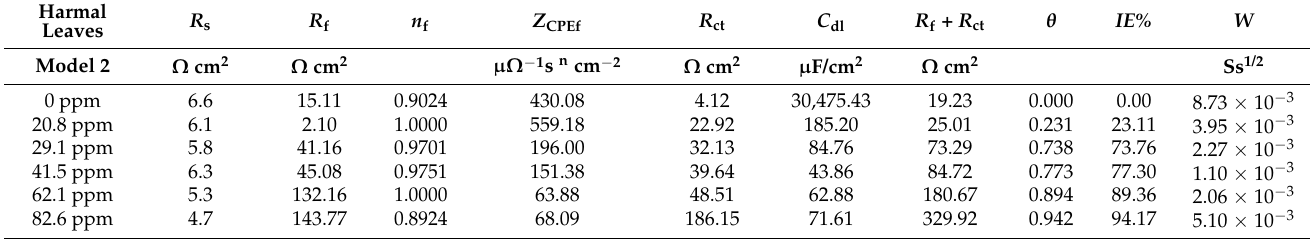
Table 4. Impedance parameters for the Harmal leaf extract on the C-steel in 0.25 M H 2 SO 4 medium by fitting the equivalent circuit model